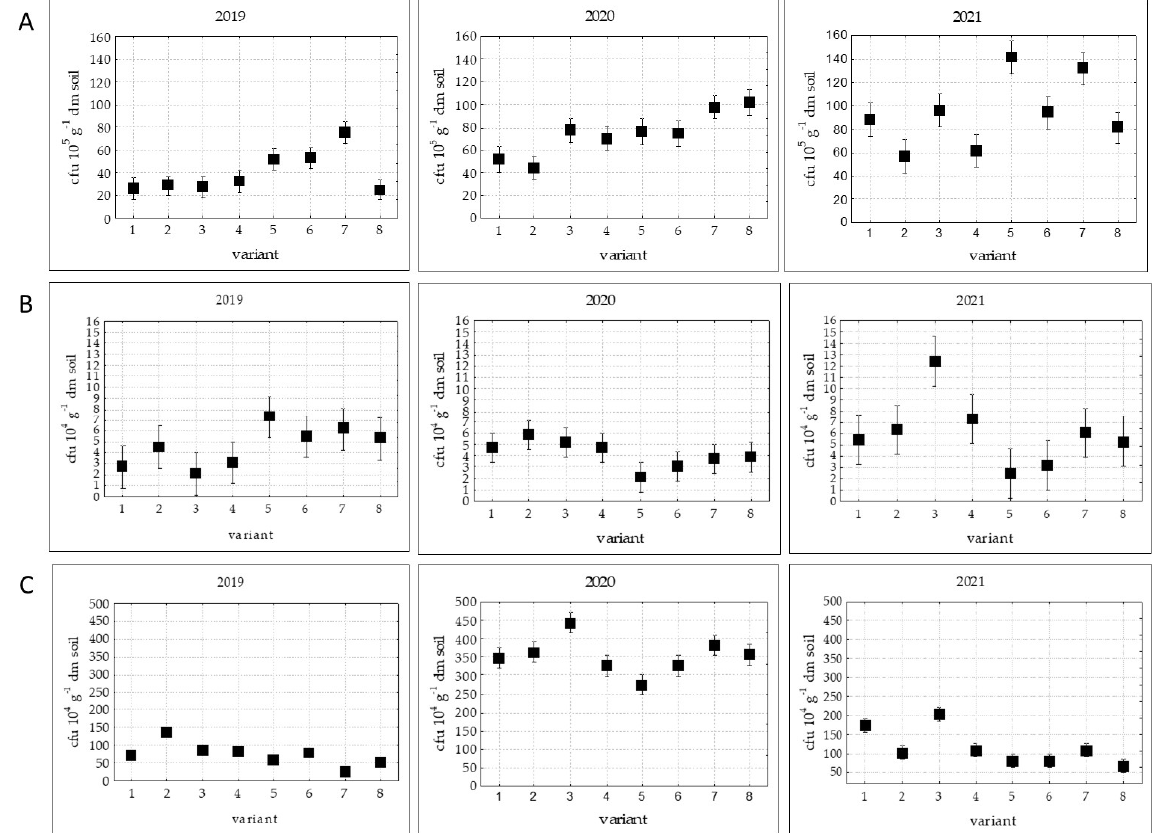
Figure 1. The number of selected groups of microorganisms in particular variants of the